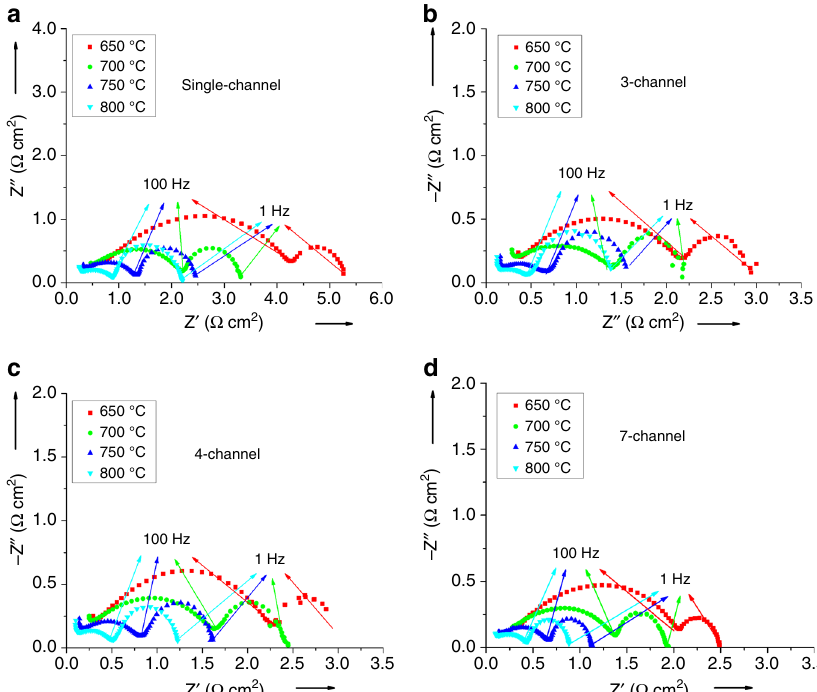
Fig. 8 Electrochemical Impedance spectra. Effects of number of anode channels of micro-monolithic SOFCs and temperature on impedance spectra (10 − 2 to 10 5 Hz) at open circuit potential